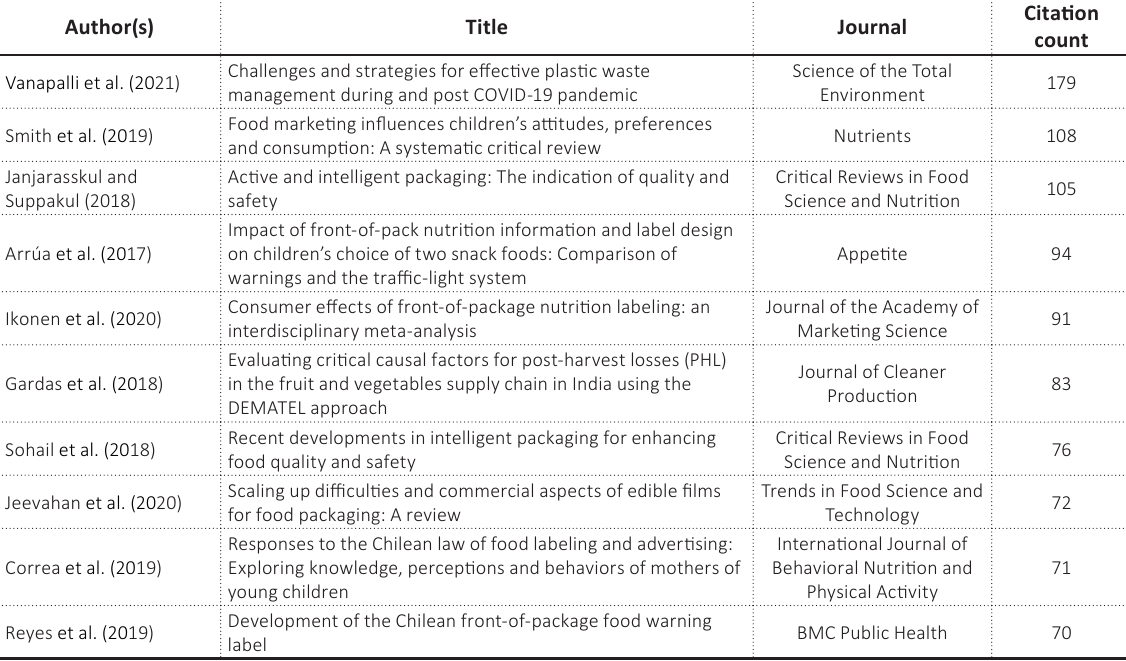
Table 1. Top 10 most influential articles for the period